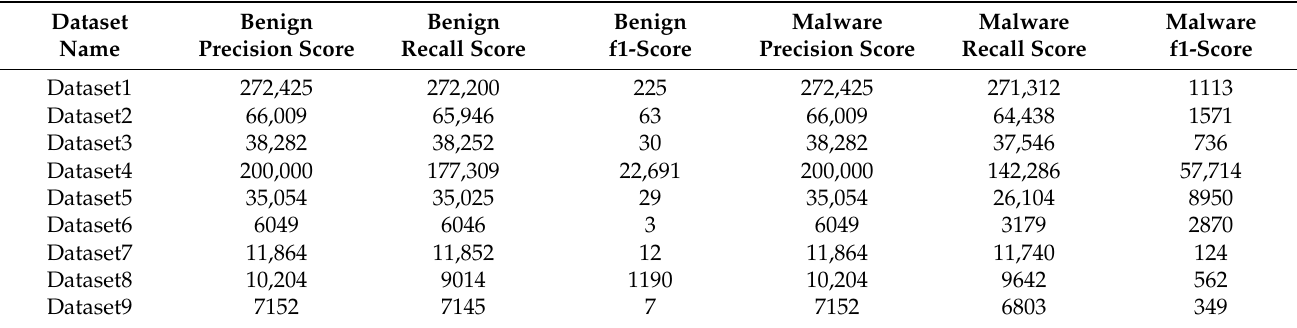
Table 7. Confusion matrix for testing with the random forest